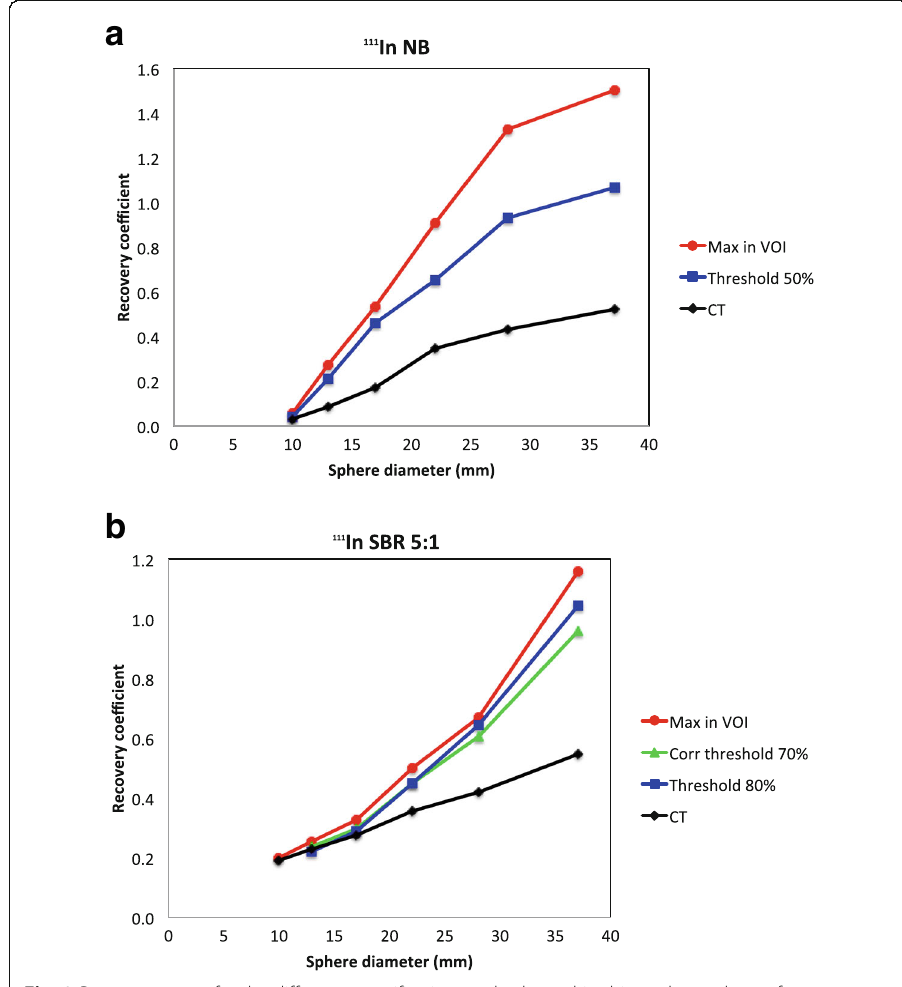
Fig. 2 Recovery curves for the different quantification methods used in this study are shown for 111 In-SPECT with no background activity ( a ) and for SBR 5:1 ( b